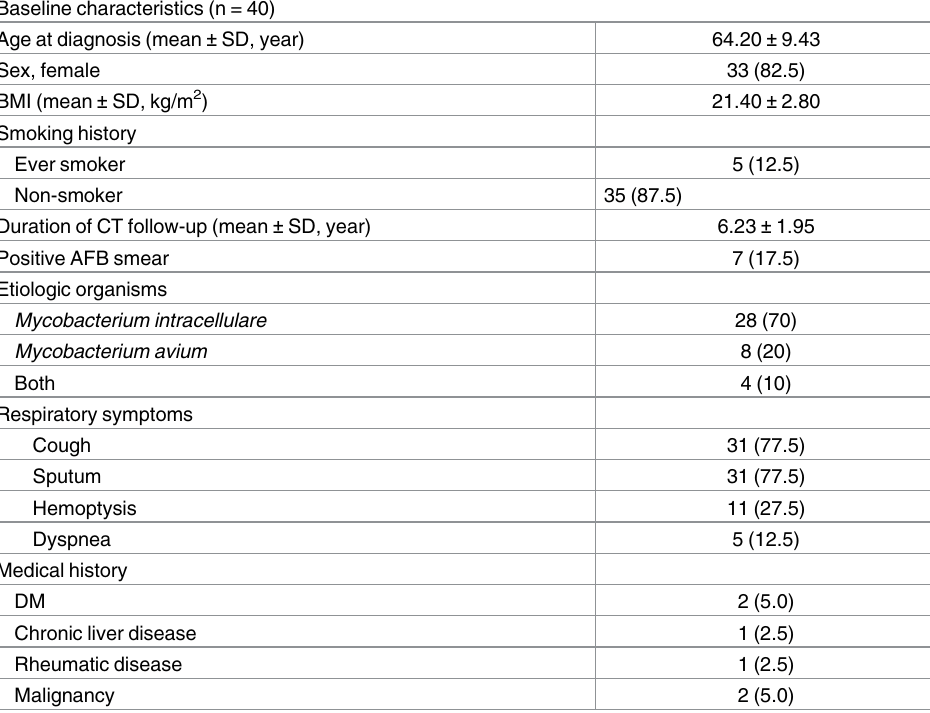
Table 2. Characteristics of 40 patients with the nodular bronchiectatic form of Mycobacterium avium complex lung